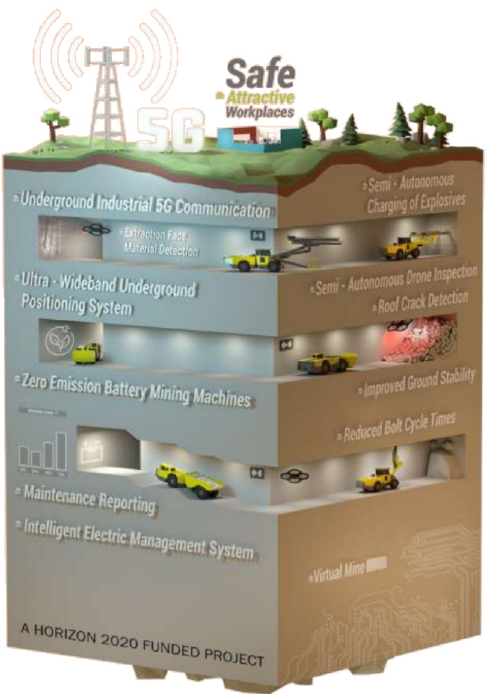
Figure 18. European sustainable intelligent mining system.